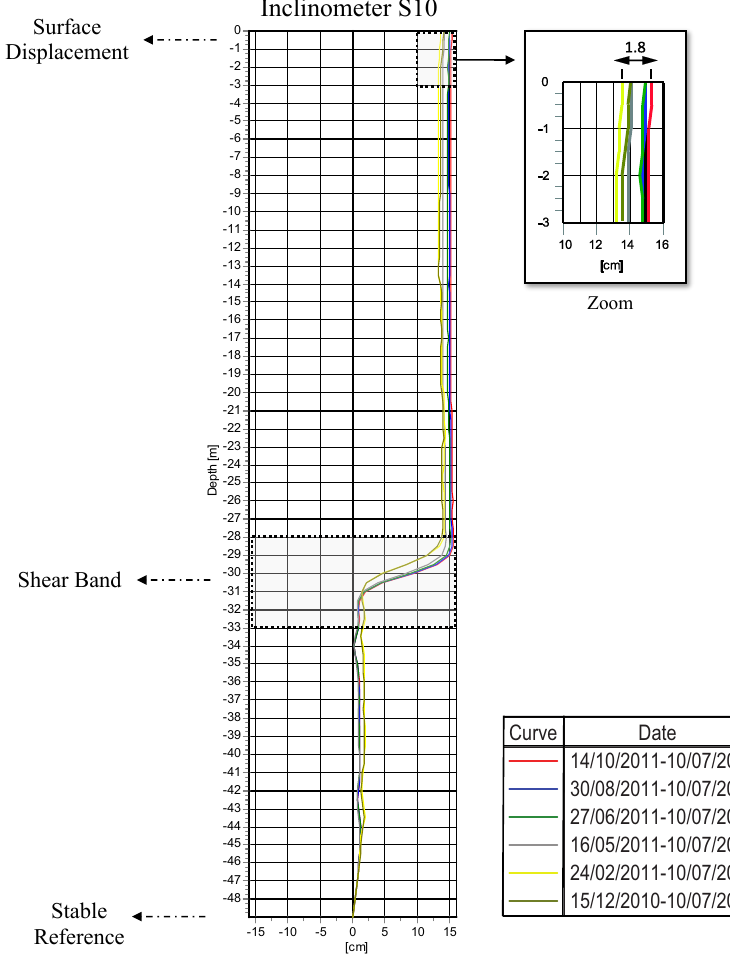
Figure 15. Inclinometric results in the borehole S10 (Cal Borró-Cal Ponet). Figure 15 illustrates the deformed shape of the inclinometer casing along the borehole for different periods. Concretely, the curves available correspond to the period from December 2010, to October 2011, all referring to July 2008. The profiles plotted correspond to the maximum displacement axis (down-slope direction). Since the displacement is produced along the steepest gradient of the slope, the orthogonal axis did not record any displacement, and for this reason, it has not been represented in the figure. As indicated by the S-shaped plot, the main shear band is located at roughly 30 m under the surface of the landslide. The upper part of the plot has been amplified to compare the inclinometric results with the ones obtained using PSI techniques. The displacement undergone by the inclinometer between the period corresponding from December 2012 to October 2013, coinciding with the PSI processing, corresponds to 1 . 8 cm. Since the inclinometric results are given in an horizontal plane, these must be divided by the cosine of the slope angle in this area ( ∼ 20 ◦ ) in order to obtain the total down-slope displacement ∼ 1 . 8 cm /cos(20 ◦ ) = 1 . 91 cm . This is equivalent to a total of roughly 2 . 3